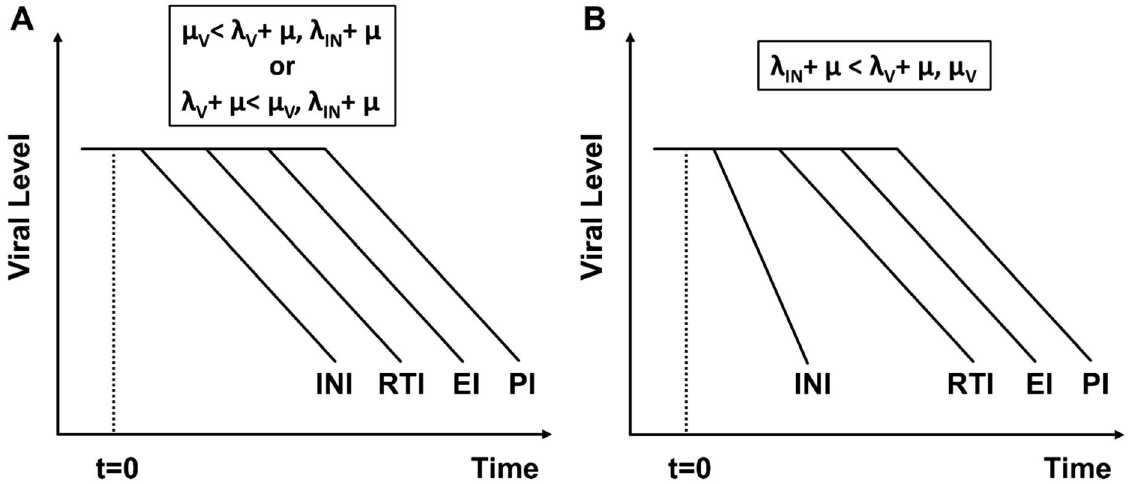
Figure 2. Illustration of the different phase IA slope possibilities in the model. (A) When the productively infected death rate is low, or the rate to viral production is low, a difference in phase IA slopes is not seen between the drug classes. (B) When the progression rate to IN complete is low compared to the productively infected death rate or the rate to viral production, a phase IA slope difference will be observed. In this case the INI will have a steeper decay than the RTI, EI, or